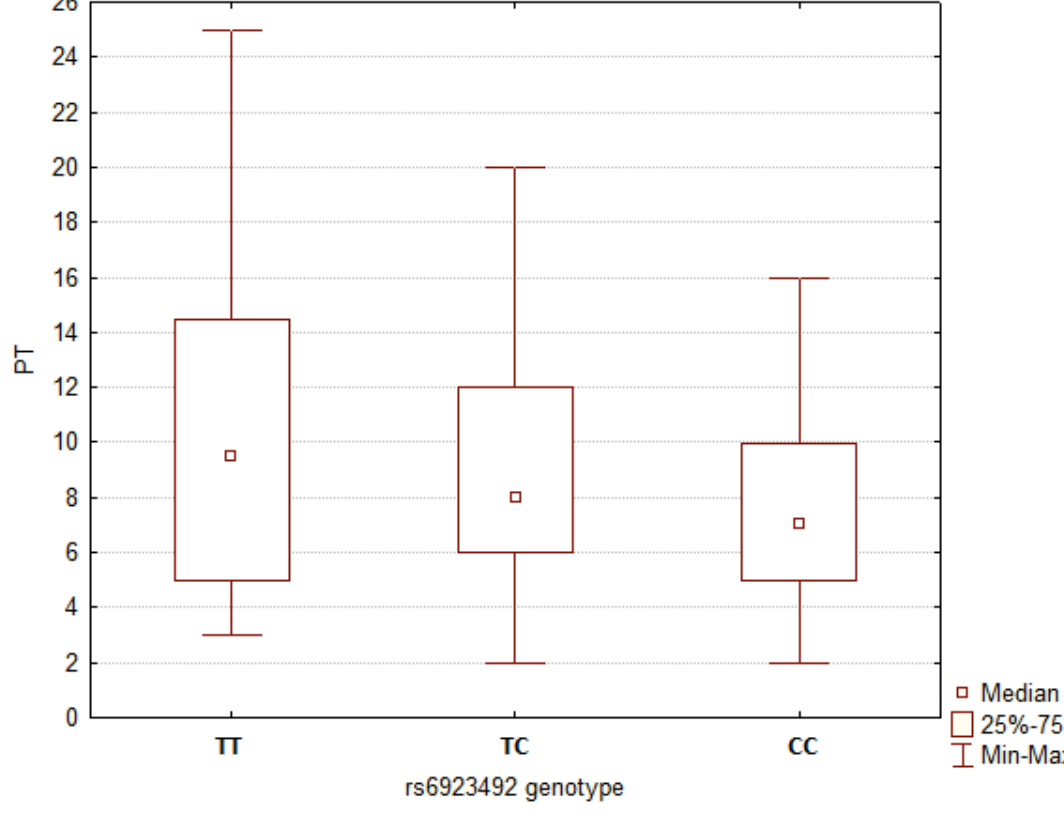
Figure 3: PT distribution for rs6923492 genotypes